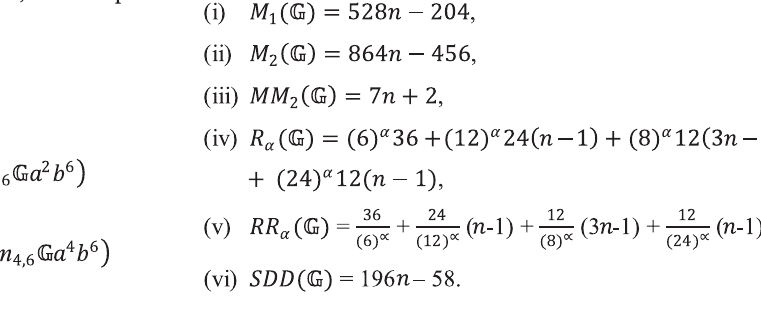
(n) for n = 2). (b) Second metal-organic network (MON 1